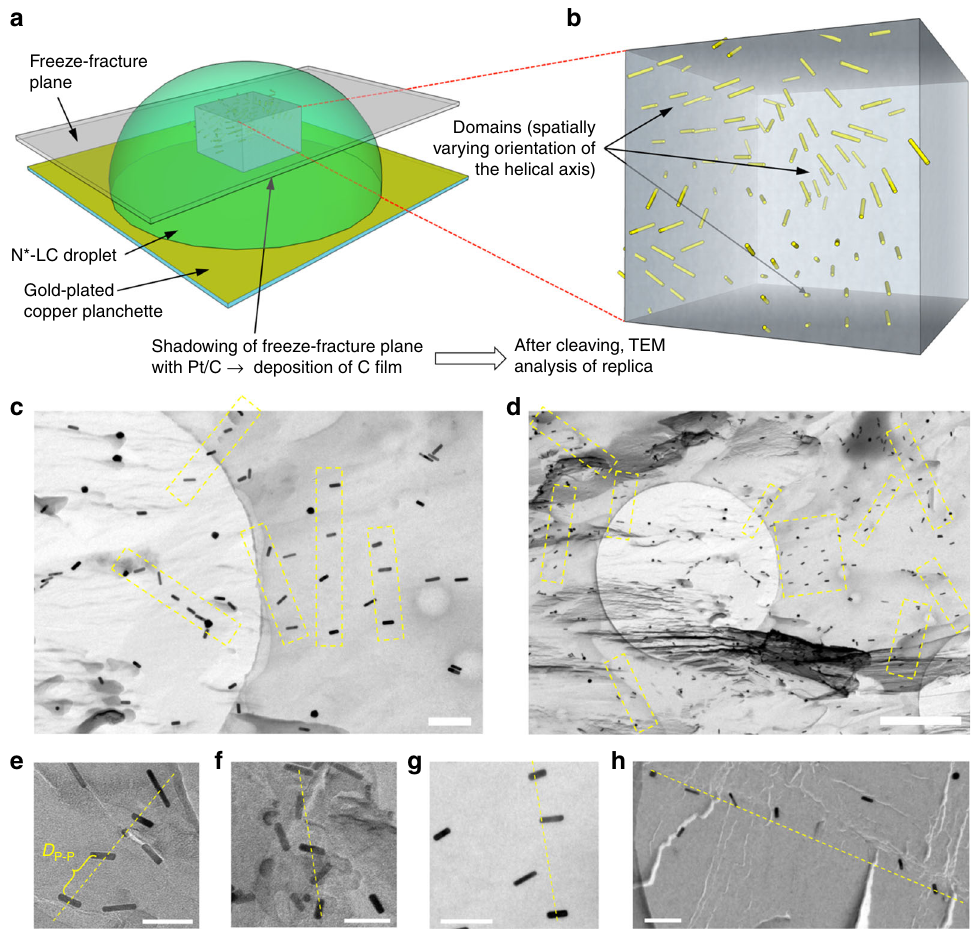
Fig. 6 Freeze-fracture transmission electron microscopy images of induced N*-LC droplets. a Schematic depiction of the freeze-fracture method to prepare the TEM specimen. b A representative voxel of the droplet showing the multi-domain structure via the embedded GNRs. c , d FF-TEM images of the induced N*-LC phase of Felix-2900 – 03 containing 0.5 wt.% GNR2 (scale bars: c 200 nm and d 1 μ m, apparent circles are from the TEM grids). To obtain these images, it was important that the replica captured most of the GNRs on the fractured surface, thereby providing a direct visualization of the GNRs in the bulk material. Areas highlighted by a yellow box and e – h select areas from many of the obtained FF-TEM images show GNR arrays (often twisted) with an average separation close to the calculated D P – P values (scale bars in e – h : 100